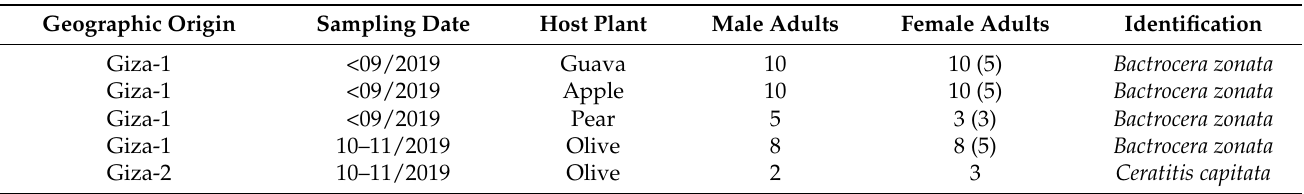
Table 3. Fruit fly sampling and identification. Numbers in brackets in the “female adults” column indicate numbers of individuals pooled for microbiome